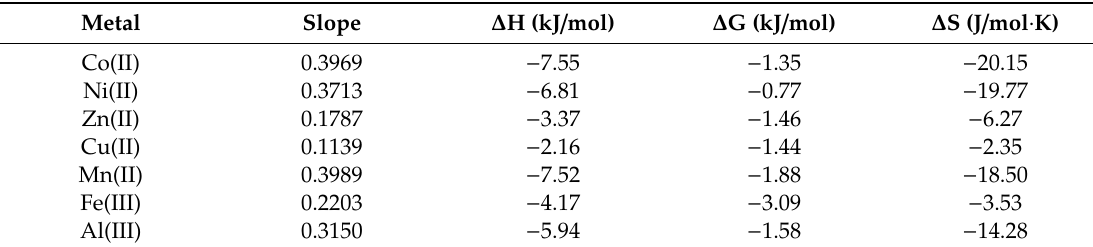
Table 3. Extraction of metals thermodynamic function